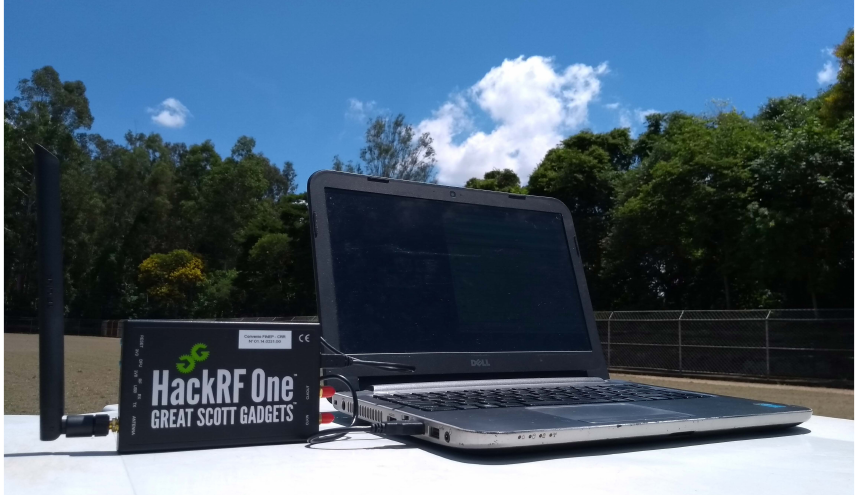
Figure 1. Hardware used to run the sensing cell module and the channel advisor (CA)